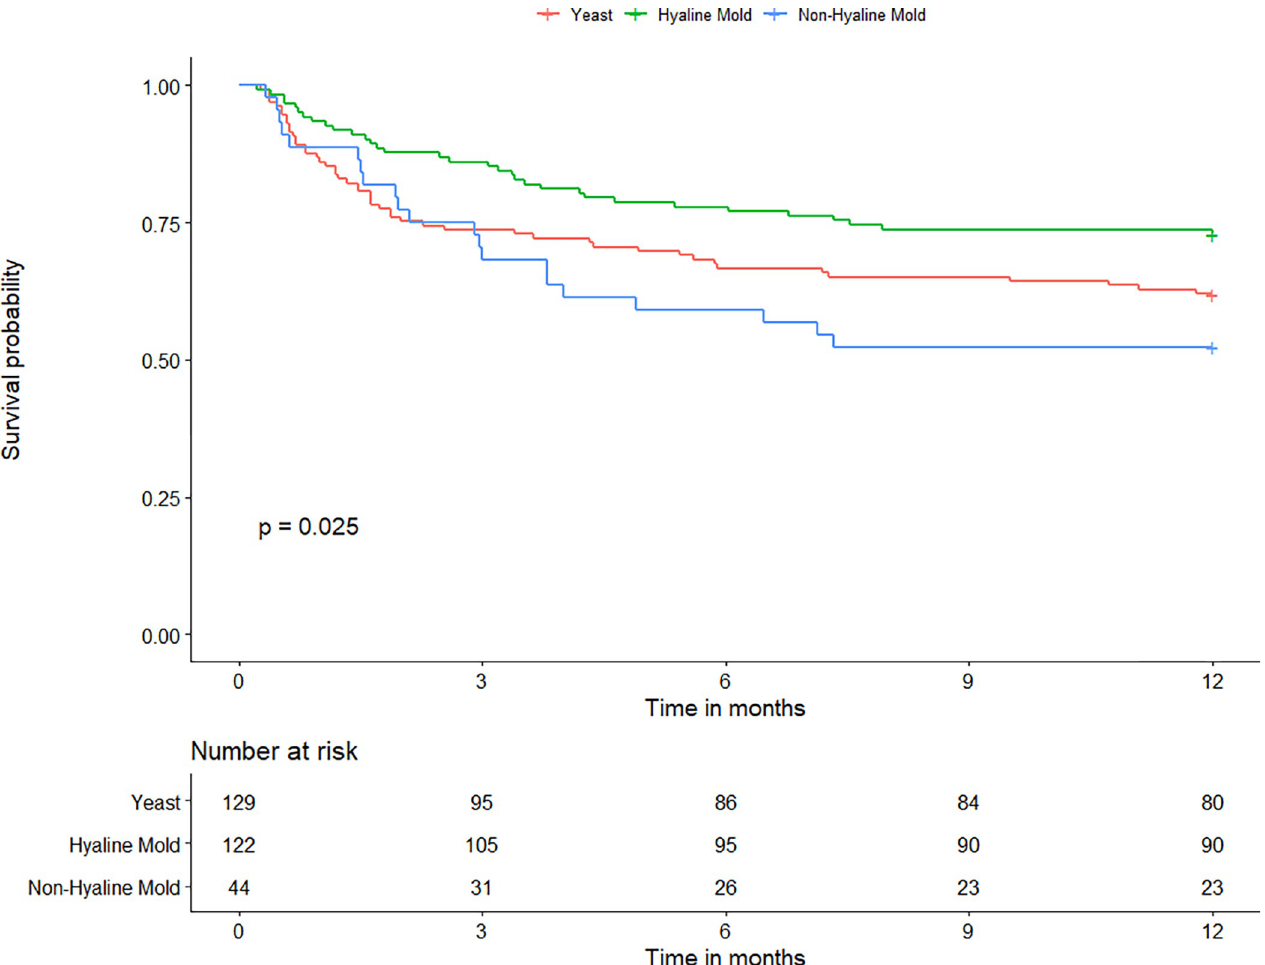
Fig 3. Kaplan-Meier curves comparing patient survival according to different types of fungal peritonitis.